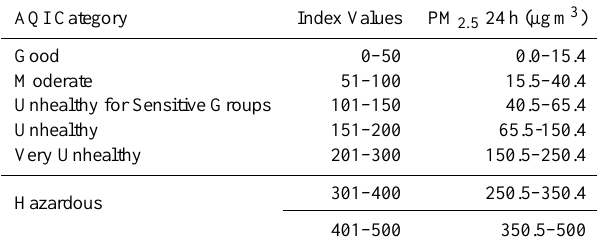
Fig. 2. AERONET sites used in this study (see Table 1 for coordi- nates and altitude).